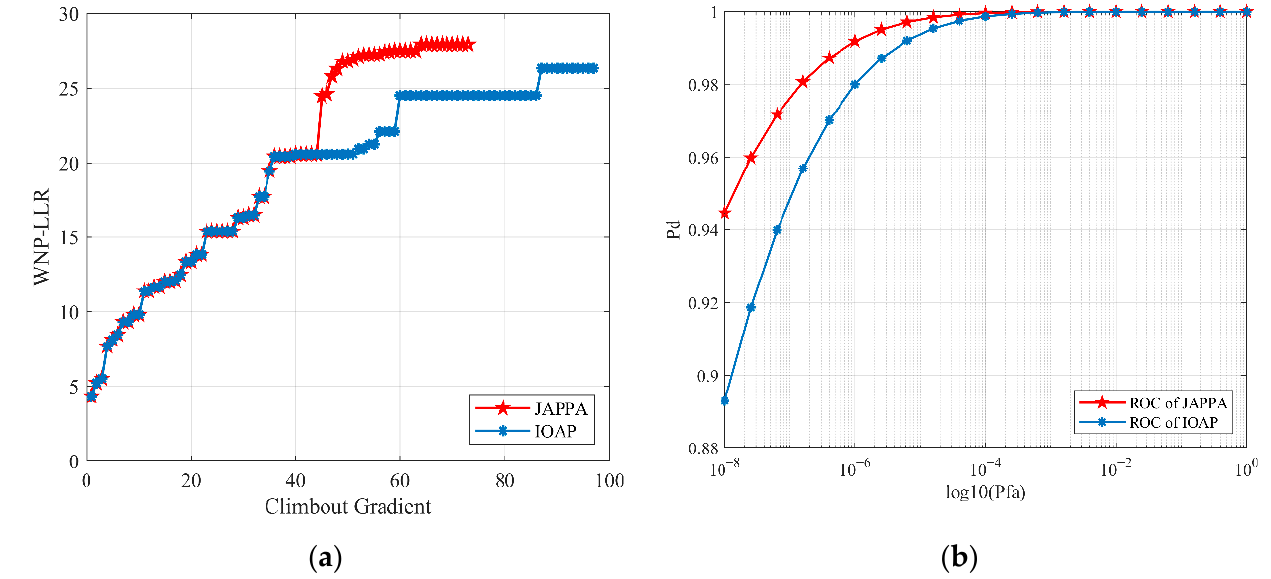
Figure 8. Simulation results comparison ( a ) optimum iterative process; ( b ) average ROC curves for IOAP and JAPPA.